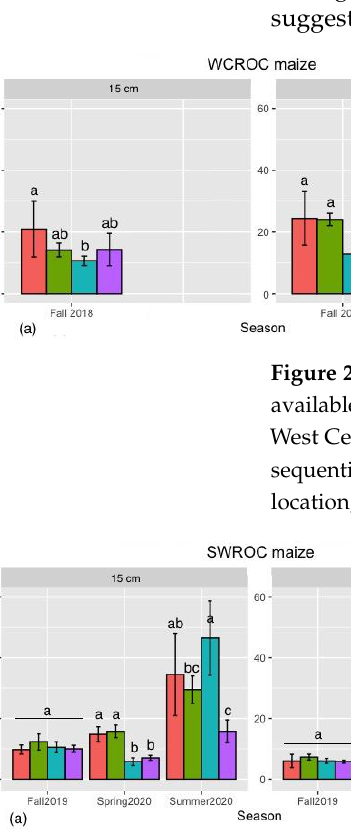
9 of 12 Figure 1. Effects of non-N-fertilized winter camelina double cropped with maize and soybean on soil available N in two soil layers: ( a ) 0 − 15 cm and ( b ) 15 − 30 cm. Vertical lines denote standard deviation. Southwest Research and Outreach Center (SWROC), 2016 – 2017. ctr = control relay, cts = control sequential, rly = relay cropping, and seq = sequential cropping. In a given season and depth within a location, bars followed by different letters are significantly different at p ≤ 0.05. In Study 2, soil available N was significantly different across seasons and depths within a location. At WCROC, soil available N was significantly different in both soil lay- ers and crops in the fall; in most instances, it was higher in the control treatments than in the treatments with winter camelina. In the fall, soil NO 3 – N was reduced by 47 and 33% under relay and sequential cropping with maize, respectively and by approximately 53% under both systems with soybean (Figure 2). At SWROC, soil available N was significantly different among the relay and sequential treatments with both maize and soybean. In spring, available N in the top 30 cm of soil was reduced to as much as 58% in the relay and 30% in the sequential cropping with maize and 33% in the top 15 cm of soil in the soybean-based cropping systems (Figure 3). These results indicate that winter camelina can significantly reduce soil available N when fertilized, but the overall high residual N suggests an increased potential for losses. In the fall, winter camelina in relay and sequential cropping with maize appears not to have affected soil available N, although double cropping with maize slightly reduced available soil N compared with controls. In spring, however, the average soil available N